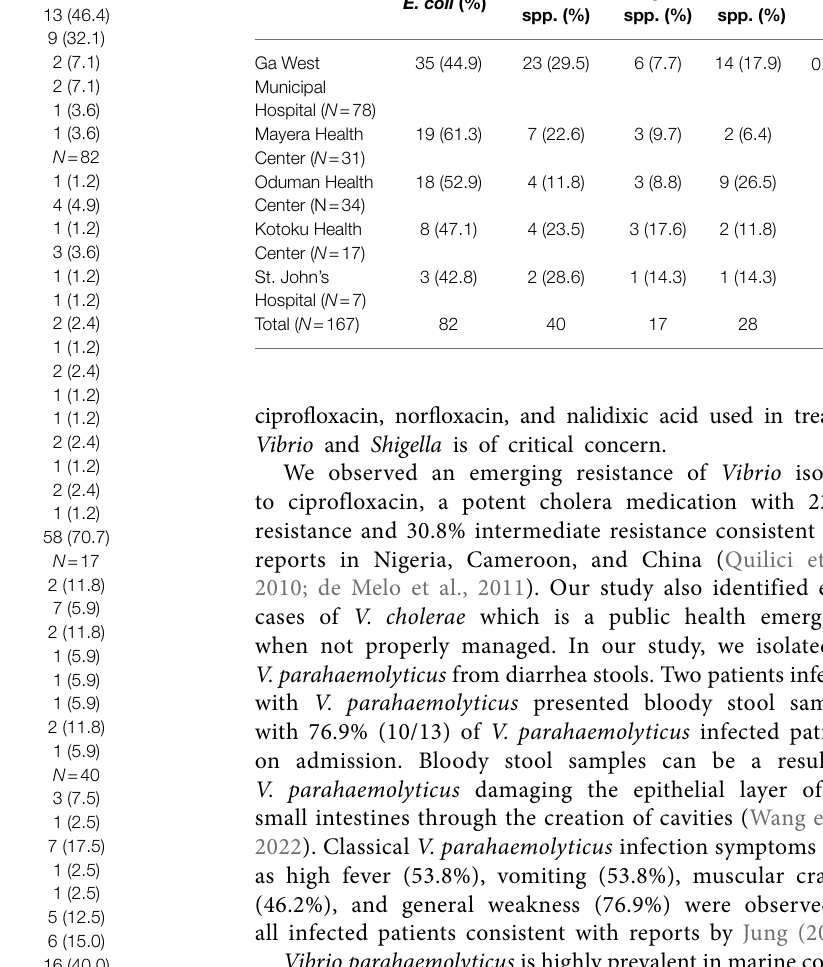
TABLE 3 | Frequency of bacteria isolated according to health facilities. Frequency of Health facility